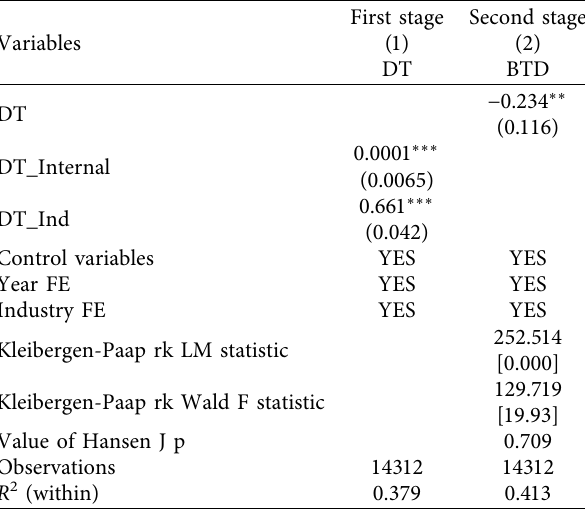
Table 7: Instrumental variable method test.